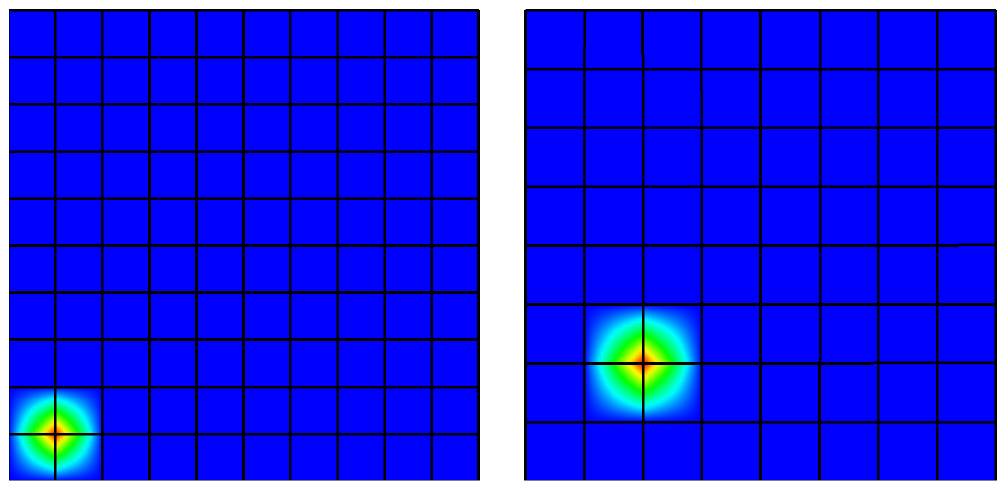
Figure 4. Mortar and non-mortar hat functions for their respective pair of mesh